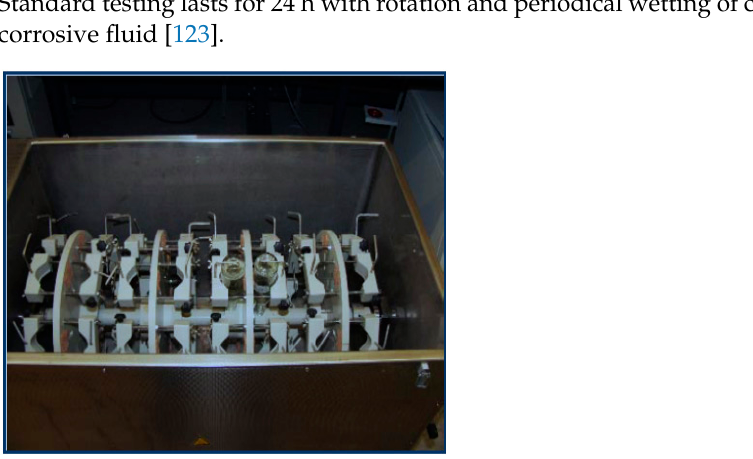
Figure 11. Equipment for qualification of corrosion inhibitors by the wheel test